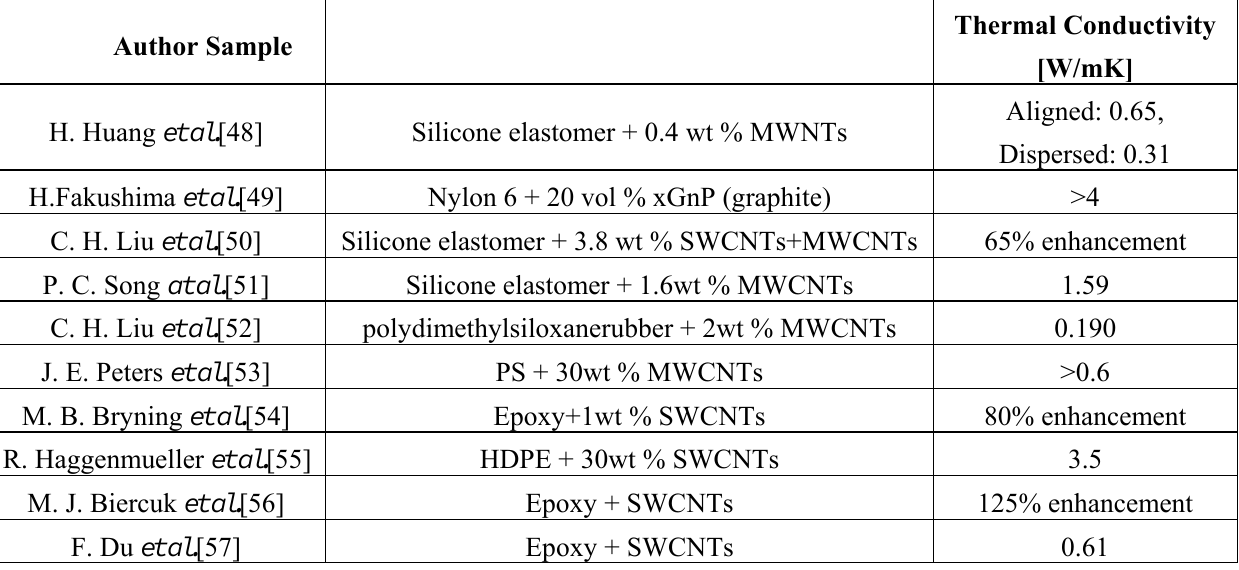
Table 3. Thermal conductivity of selected